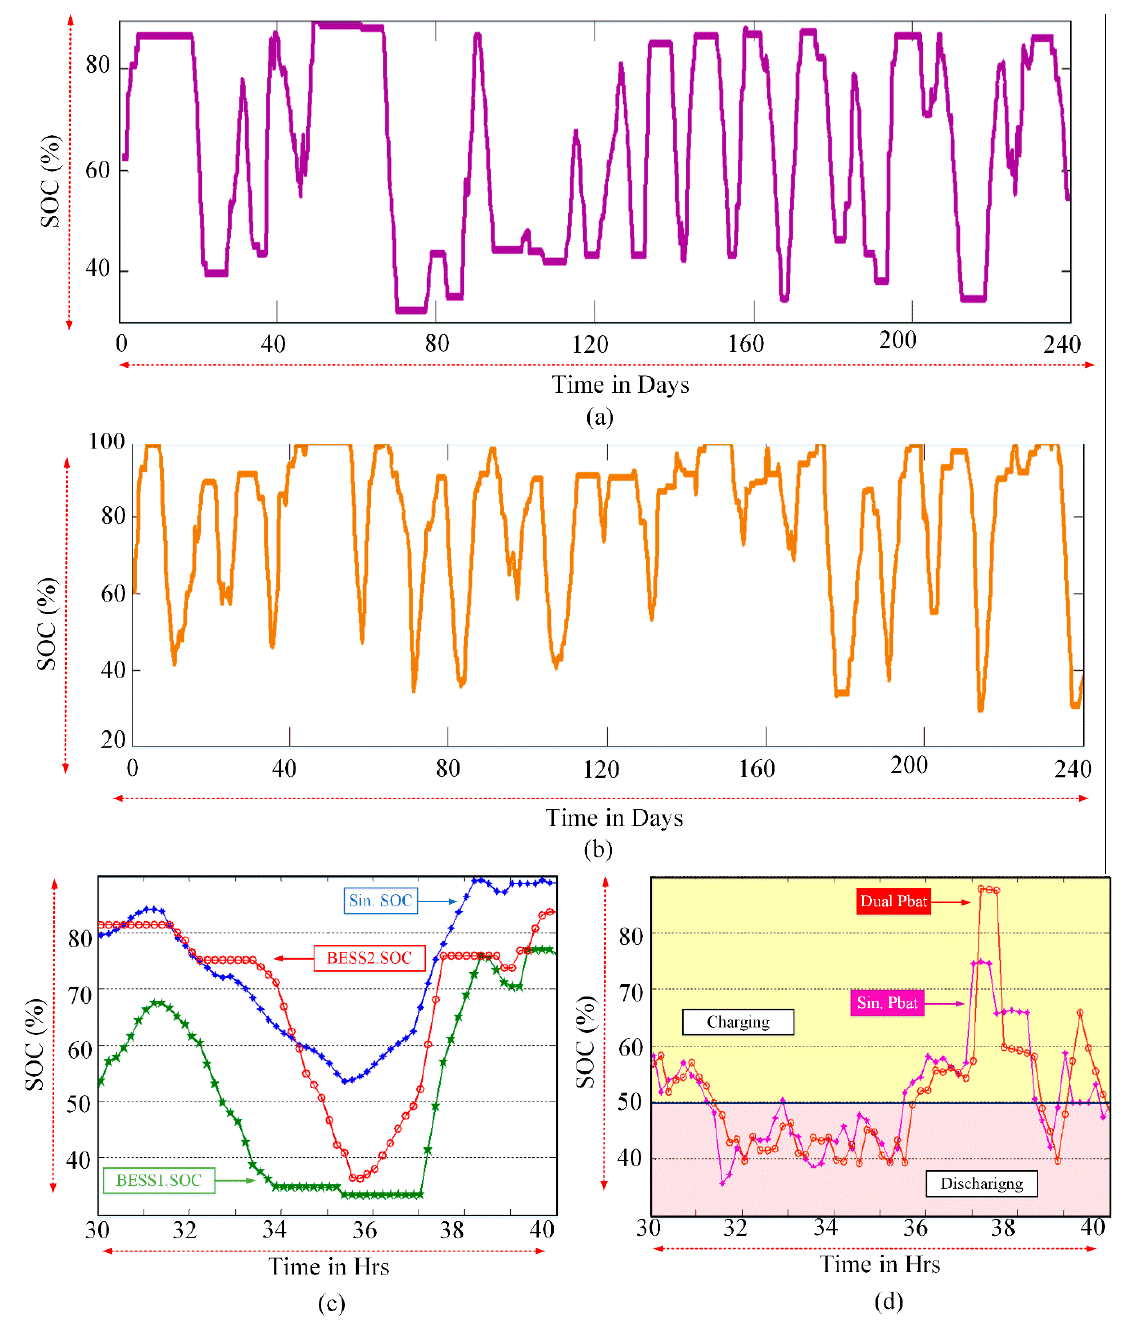
Figure 7. ( a ) State of Charge of Dual module BESS 1 ( b ) State of Charge of Dual module BESS 2 ( c ) State Figure 7. ( a ) SOC of Dual module BESS 1 ( b ) SOC of Dual module BESS 2 ( c ) SOC of batteries in both of Charge of batteries in both cases for 10 h. ( d ) Power discharged from batteries in both cases for 10 cases for 10 h. ( d ) Power discharged from batteries in both cases for 10 h.